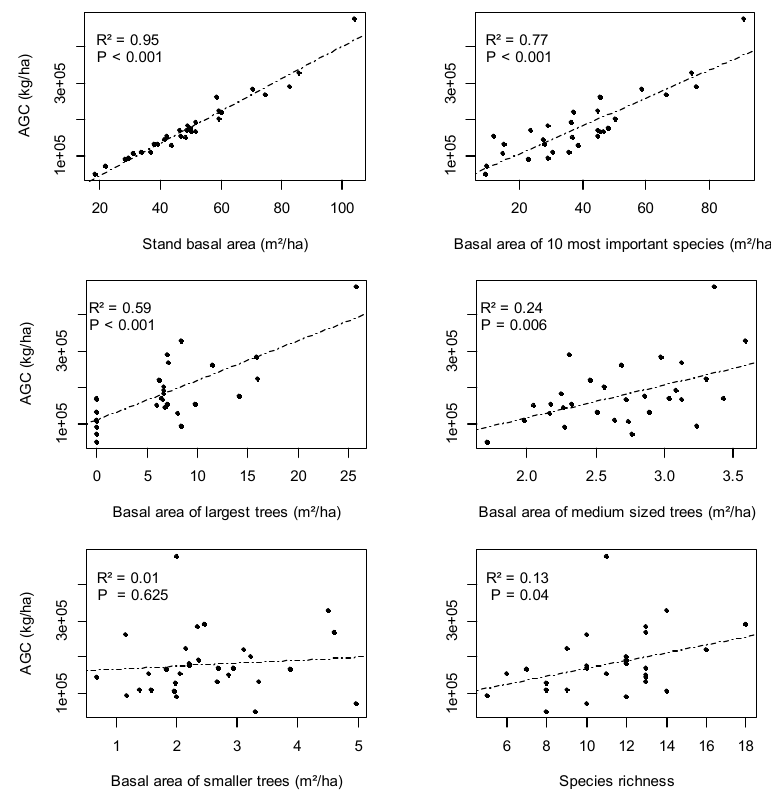
Figure 5. Bivariate relationships between aboveground carbon (AGC) and stand variables.